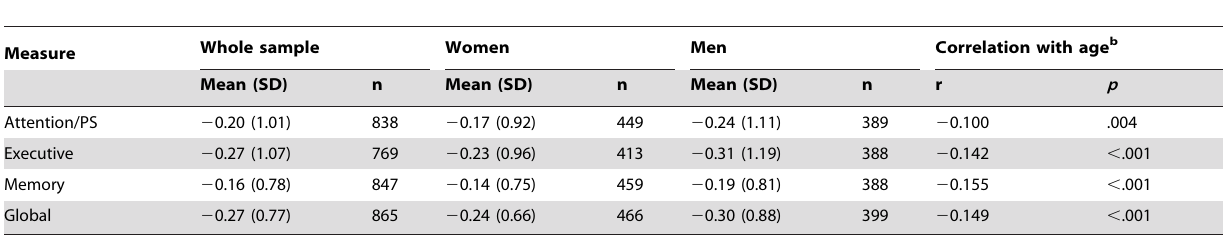
Table 2. Change in cognitive performance a